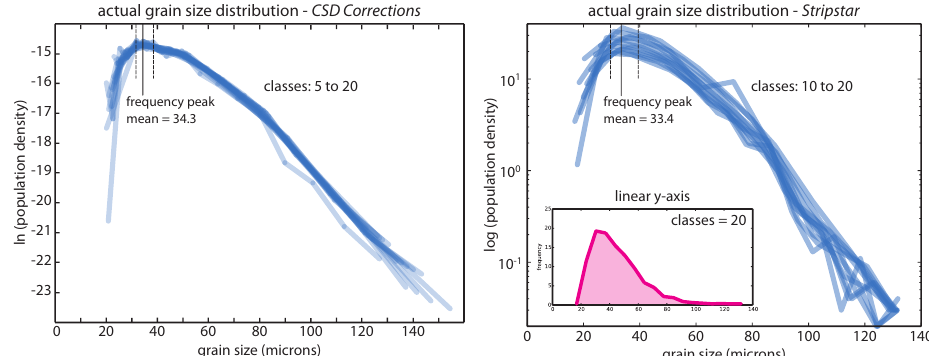
Figure 11. Estimated actual 3-D grain size distribution from sample MAL-05 performed with CSD Corrections (left) and StripStar (right). To draw the lines, the middle values of each bin estimated by the applications were used, taking into account different number of classes. The frequency peak grain size and other statistical parameters of interest were calculated using all the middle values of the modal intervals obtained. The inset (on the right) is the curve estimated by StripStar considering 20 classes but using on the vertical axis a linear scale instead of logarithmic. Note that the actual 3-D grain size curve shows similarities to a log-normal grain size